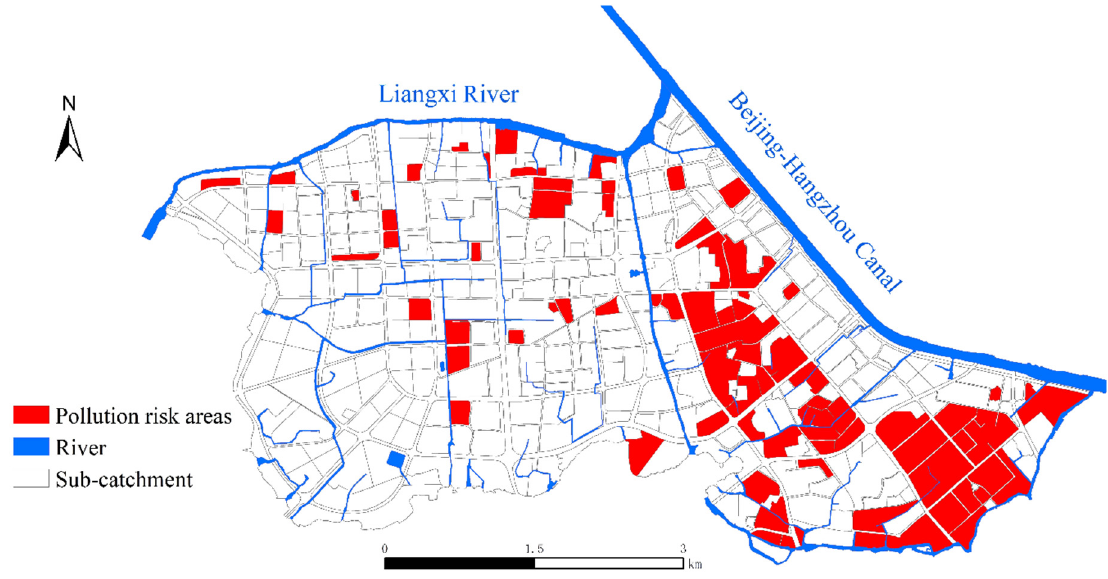
Figure 6. Surface non-point source pollution risk areas.